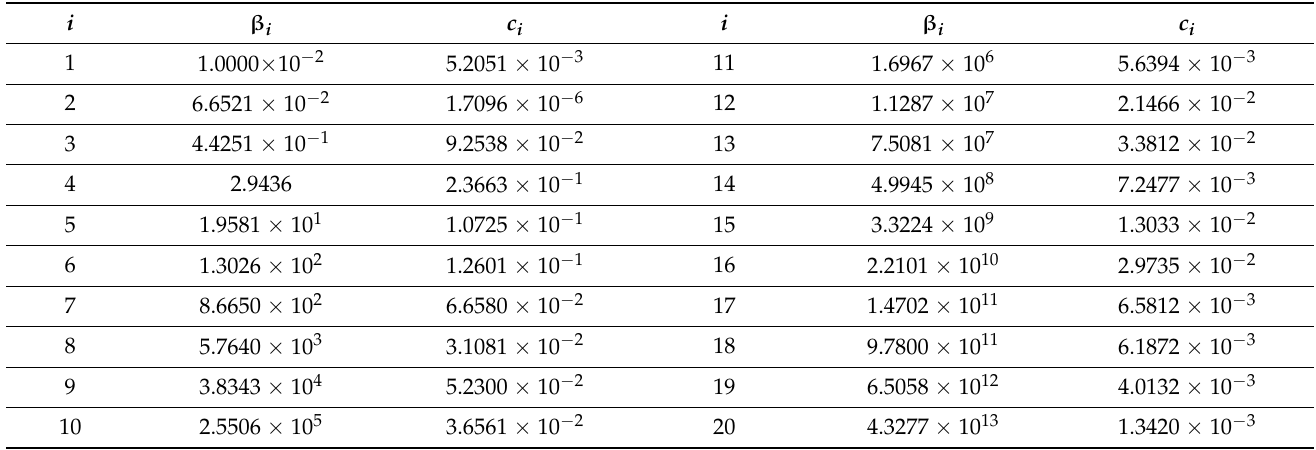
Table 1. The values of approximation coefficients of the generalized relaxation function for the mandrel material.